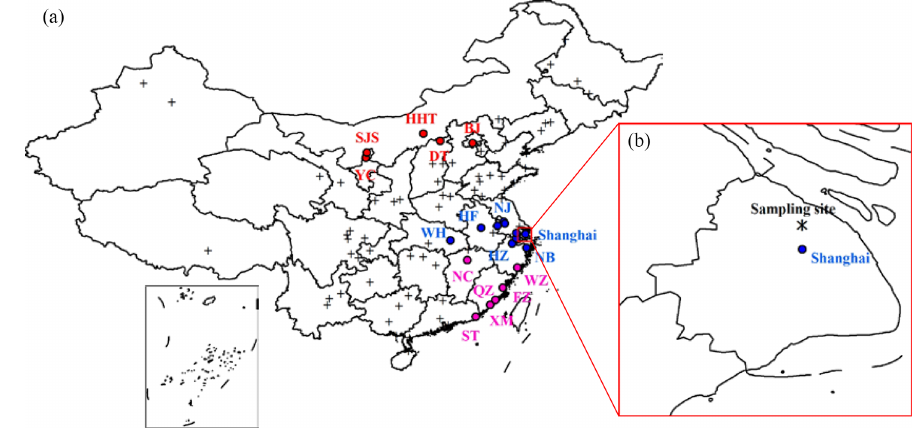
Figure 1. (a) Locations of the 86 major cities in China. The cities with PM 10 concentrations up to 600µgm − 3 on 20, 21, and 22 March are marked by red, blue, and pink circles, respectively. (b) The site location of the ground-based measurement in